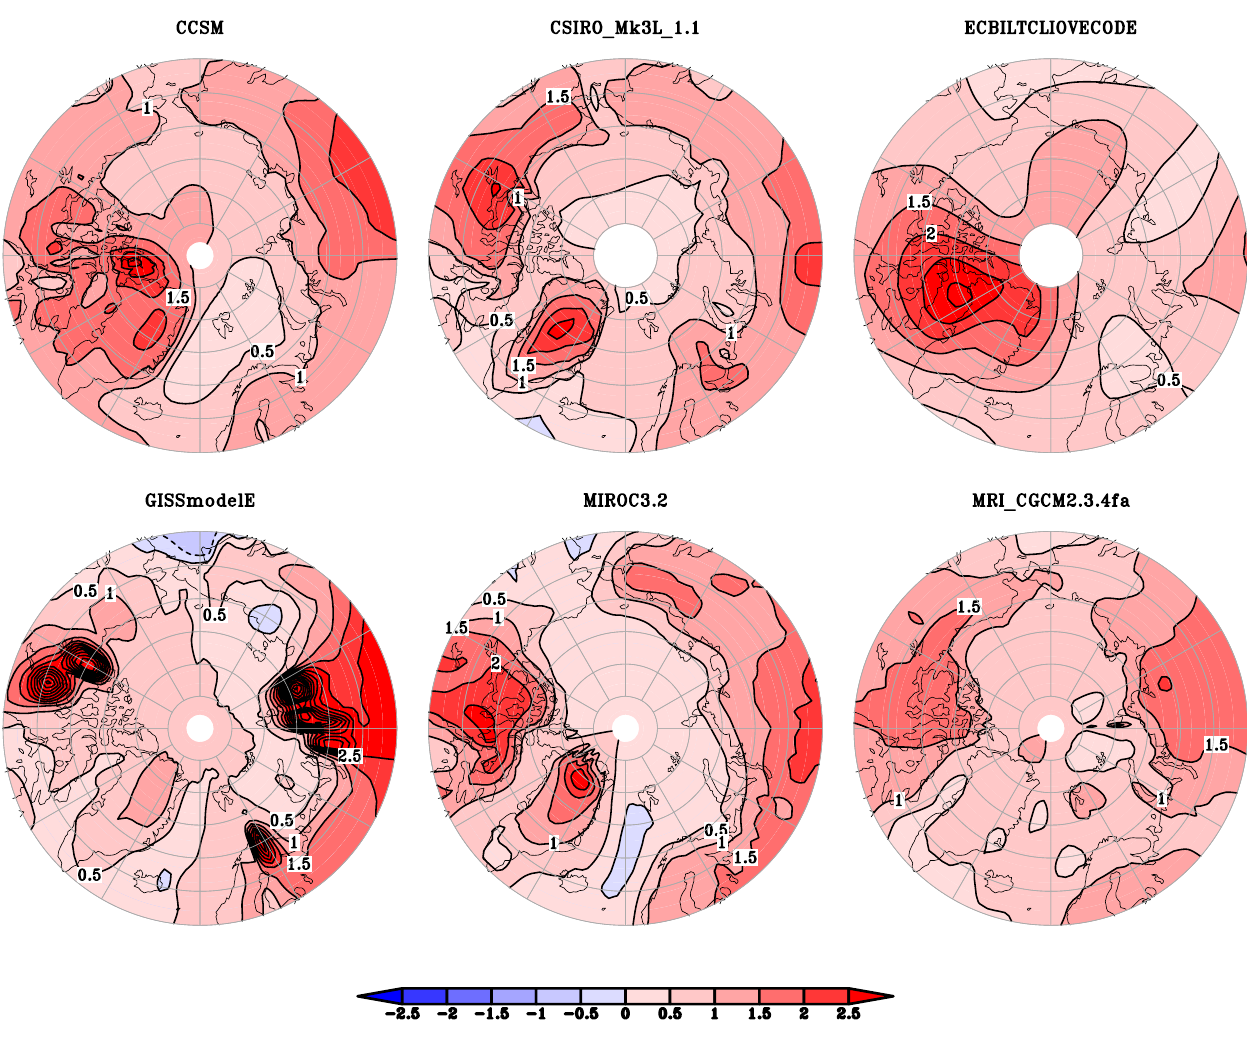
Fig. 4. Summer mean (JJA) change in surface temperature ( ◦ C) in six selected PMIP2-OA models.